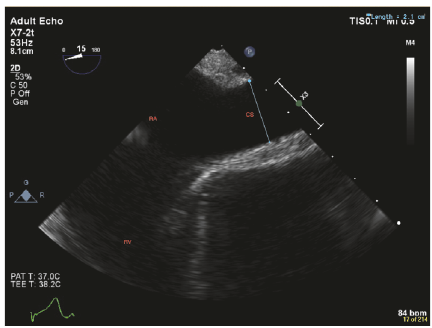
Figure 2: Deep midesophageal 4-chamber view showing a dilated coronary sinus (2.1cm). RA = right atrium, RV = right ventricle, and CS = coronary sinus.